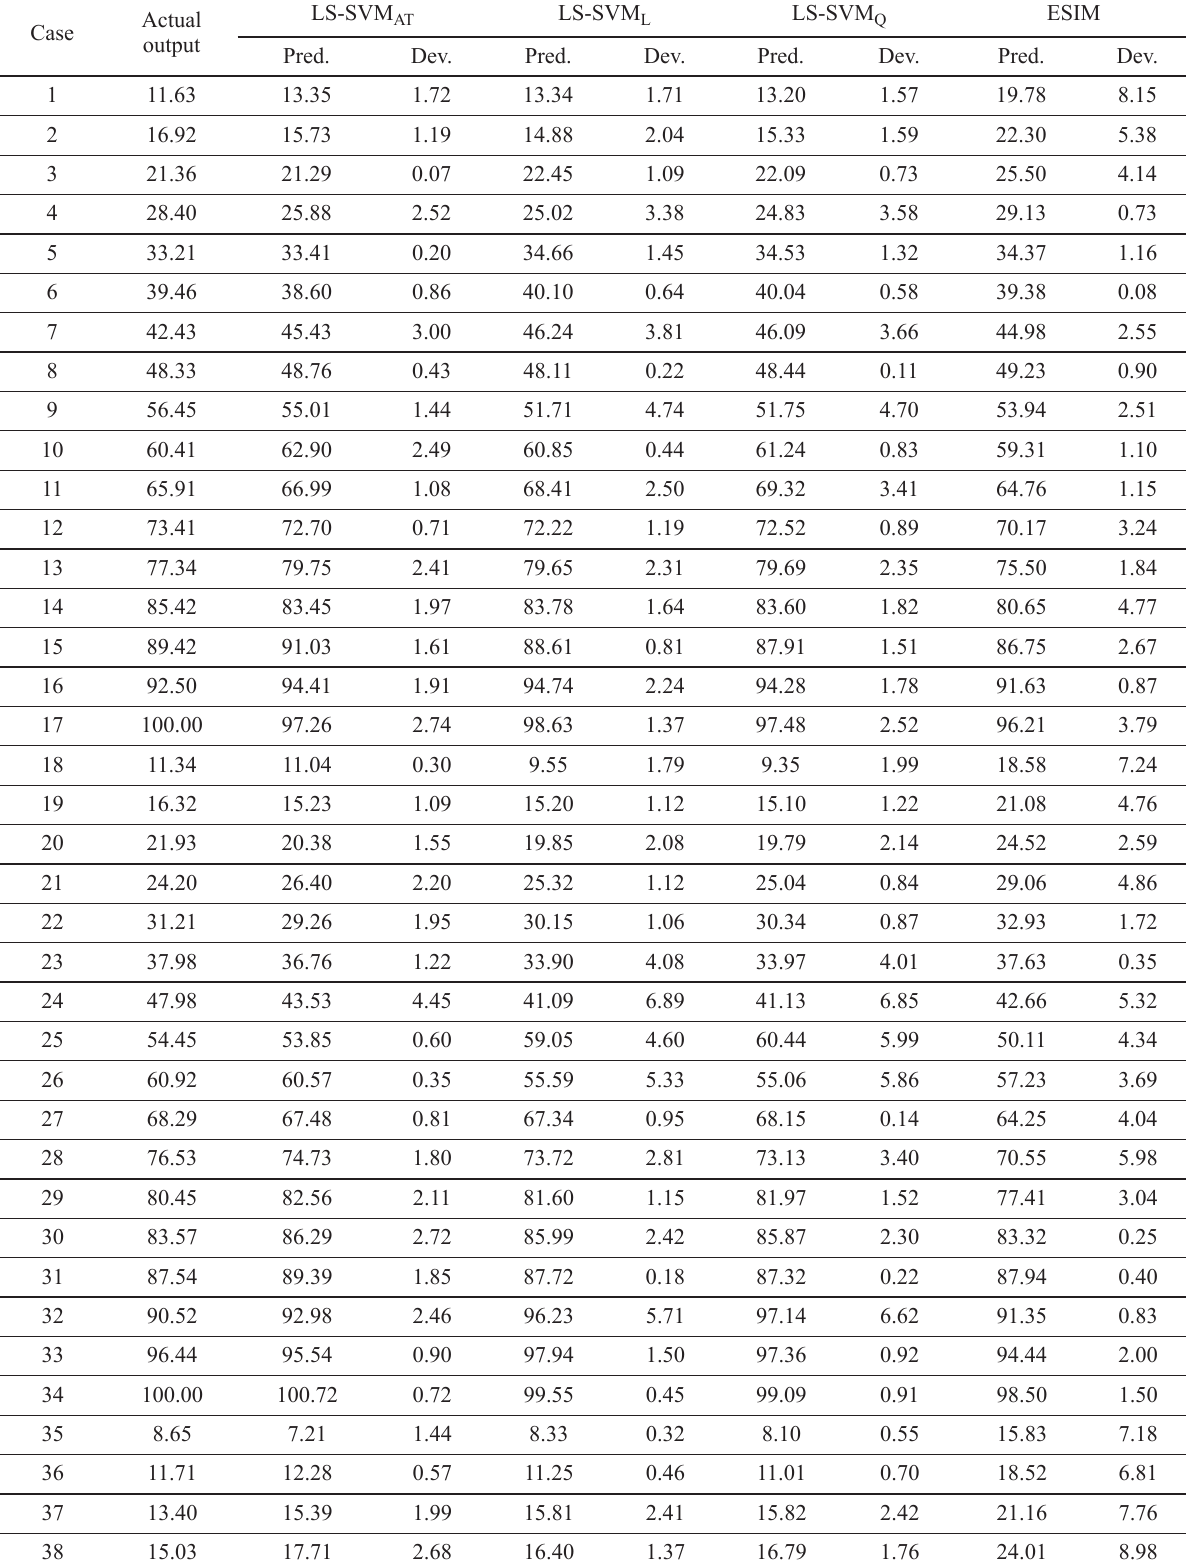
Table 3. Detailed result of testing